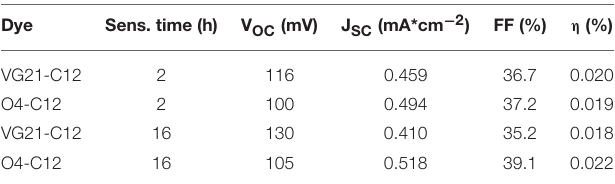
TABLE 2 | Photoelectrochemical parameters of VG21-C12 and O4-C12-sensitized NiO-based DSCs.